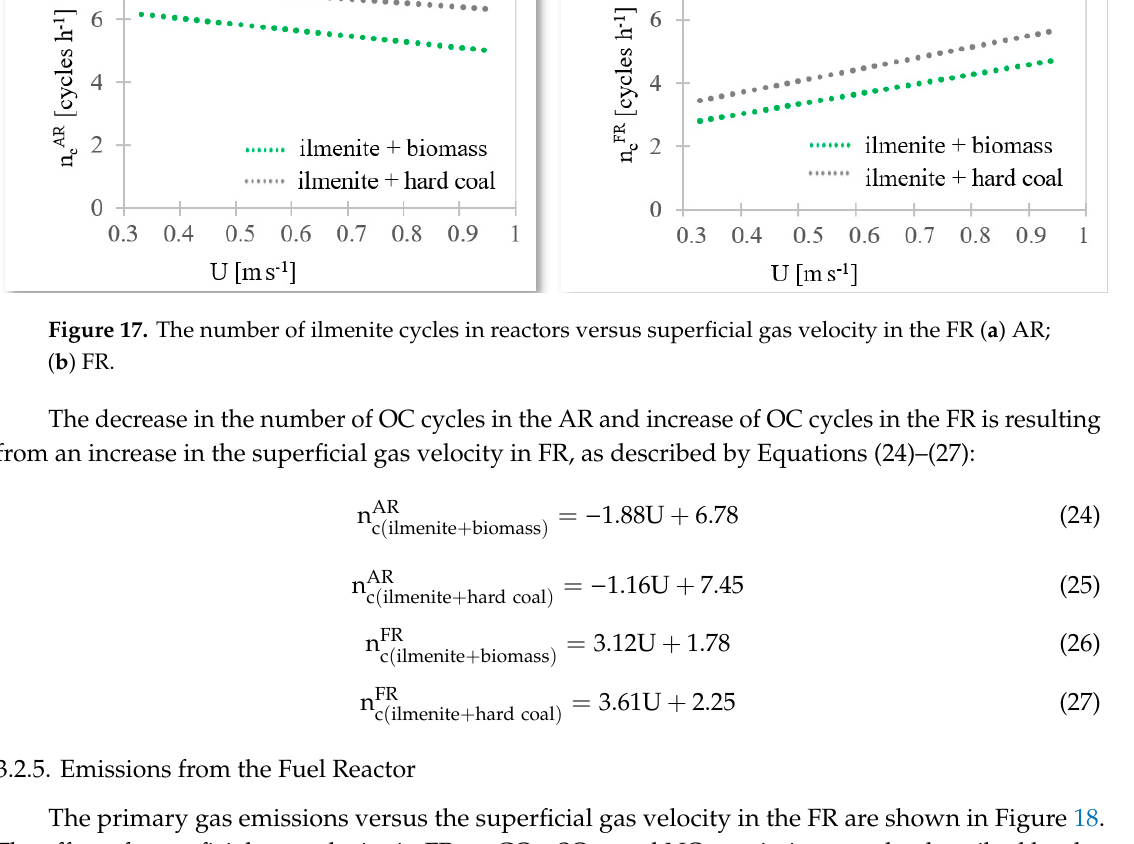
Figure 17. Energies 2020 , 13 , x FOR PEER REVIEW